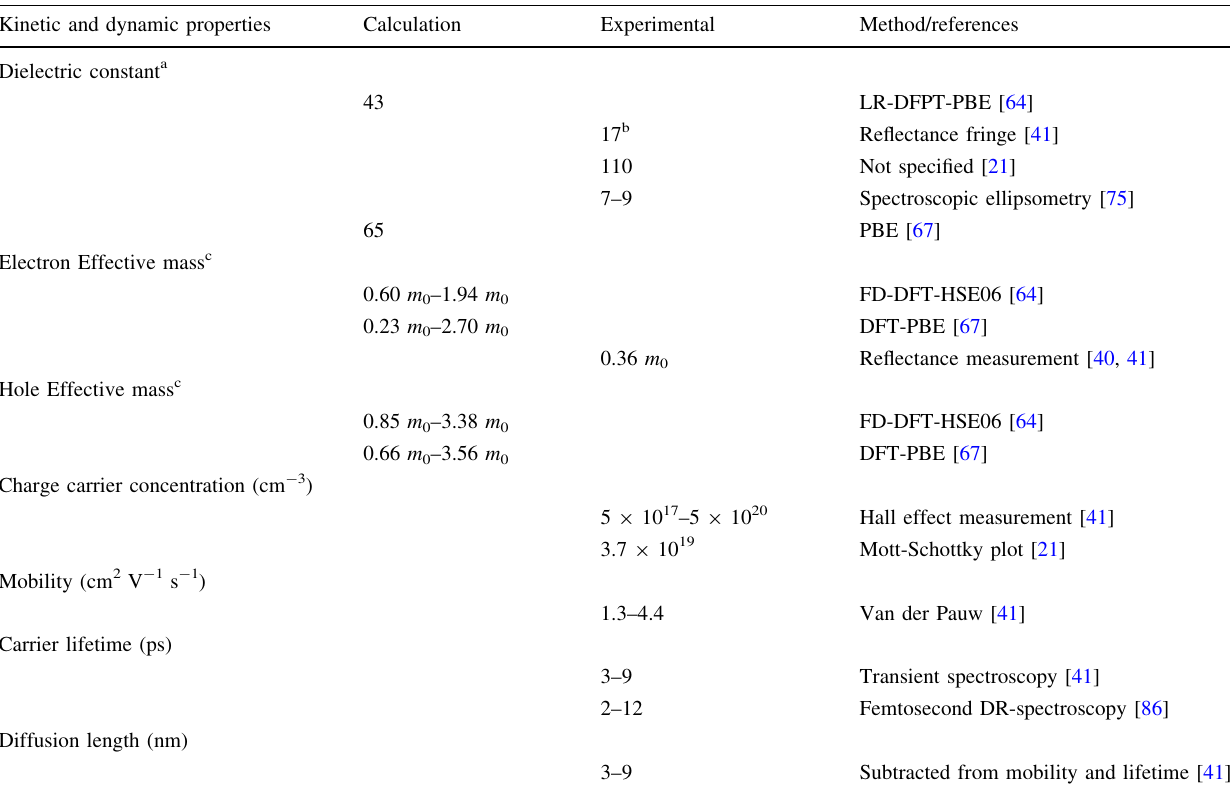
Fig. 6 a Imaginary part of the frequency-dependent dielectric function along with the three principal light polarization vectors computed at the DFPT/HSE06 level of theory for Ta 3 N 5 utilized for dielectric constant calculation. Red , blue , and green curves Table 3 Ta 3 N 5 kinetic and dynamic properties Kinetic and dynamic